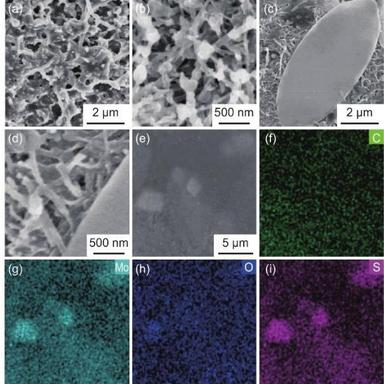
a, b) SEM images of the CNT-coated separator after discharging, (c-e) SEM images of the 30MoO2/CNT-coated separator after discharging, and (f-i) the corresponding element mapping images of C, Mo, O and S.